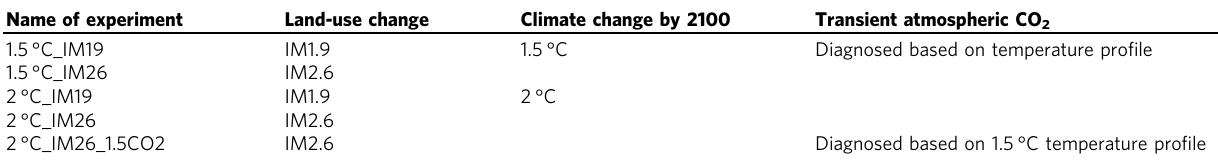
Table 1 Summary of experiments. IM1.9 and IM2.6 refer to the IMAGE versions of the Representative Concentration Pathways for 1.9 and 2.6 W m -2 radiative forcing by 2100 (see Fig. 1e, f for a snapshot of changes in each scenario)